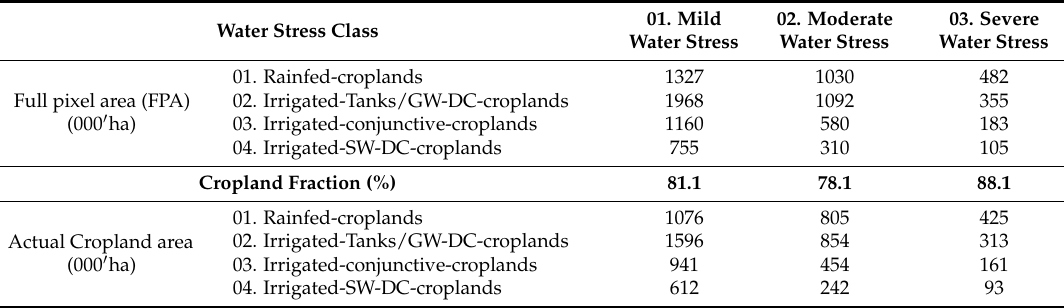
Table 4. Changes in irrigated agricultural cropland from 2013–2014 (a normal year) to 2015–2016 (a water-deficit year) as a response to water stress, where FPA = full-pixel area; CAF = crop area fraction; SPA = and sub-pixel area or actual area. SPA = FPA ×